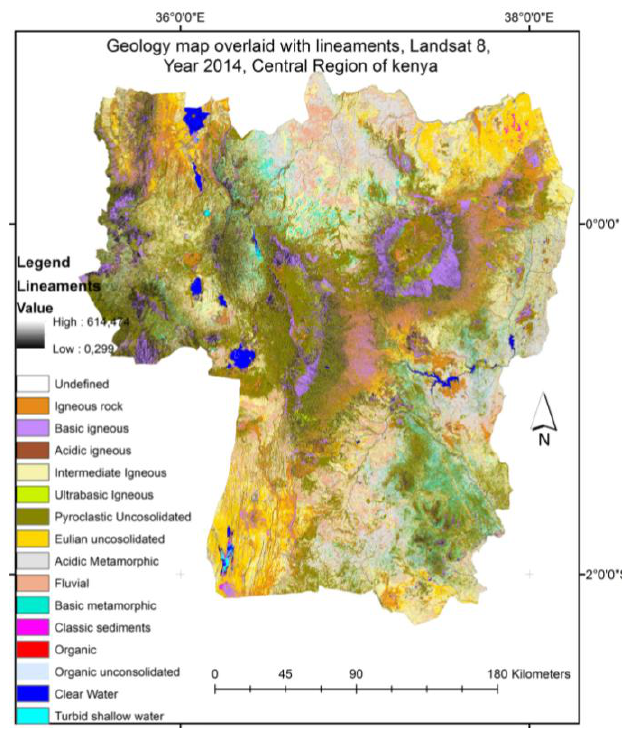
Figure 8: Structural geology map, Landsat 8 The RGB comprising edges from band ratio 5/1, band 8 and slope (Figure 9), achives visualization of the lineaments through a shaded relief. However, band 8 effect is captured as it overlaps with bands 4 and 2, which are mainly vegetation bands. Therefore the lineamnets on vegetated areas are not as clear.